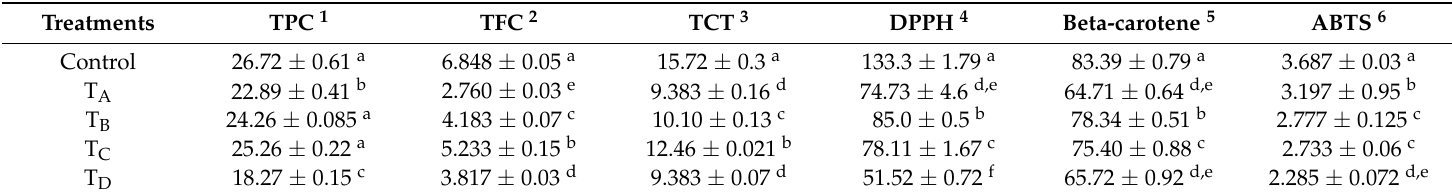
Table 1. Antioxidant components and antioxidant activities of PHF extracts microencapsulated with gum arabic (GA), gelatin (GE), maltodextrin (MD) and their combinations by Freeze-drying